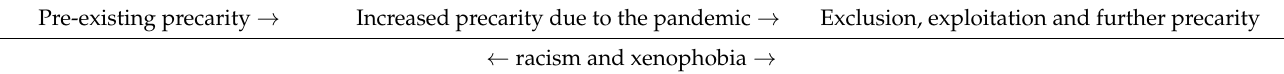
Table 1. Precarity and racism during the COVID-19 pandemic. Pre-existing precarity